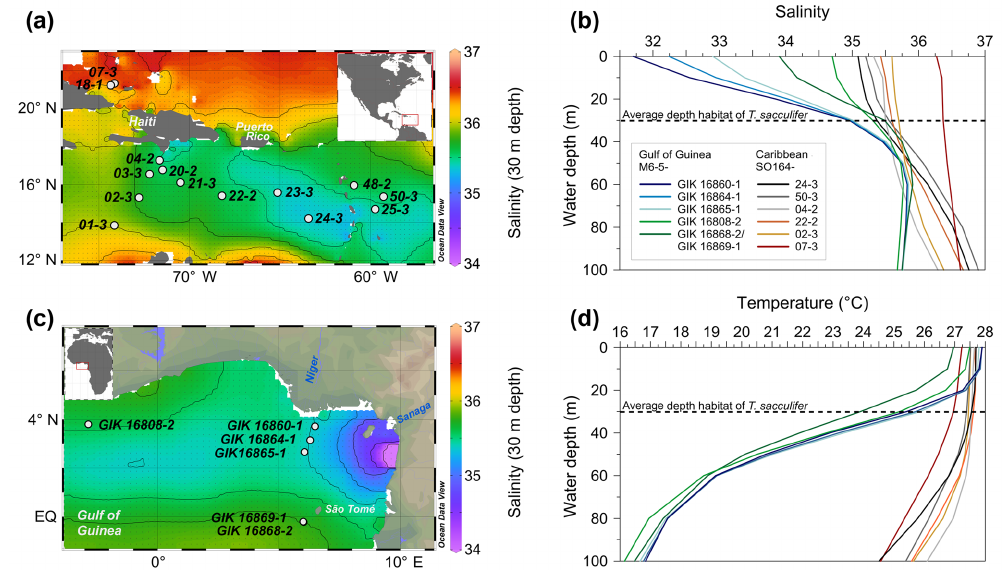
Figure 1. Sediment surface samples used for Na / Ca calibration studies (a–b) and modern hydrography in the study areas (c–d) . (a) Annual sea surface salinity in the Caribbean at 30m of depth (World Ocean Atlas 2013; Zweng et al., 2013). Surface sediments (white dots) were taken during RV Sonne cruise SO164 (Nürnberg et al., 2003). (b) Annual sea surface salinity in the Gulf of Guinea at 30m of depth (World Ocean Atlas 2013; Zweng et al., 2013). Sediment samples (white dots) are from RV Meteor cruise M6–5 (Lutze et al., 1988). Station numbers are indicated (Table 2). Maps were created with Ocean Data View (Schlitzer, 2015). (c) Annual range of salinities and (d) temperatures from 0 to 100m of water depth in the Caribbean and the Gulf of Guinea (World Ocean Atlas 2013; Zweng et al., 2013; Locarnini et al., 2013). Sample stations are color coded (see legend). Stations of Caribbean surface sediments, which are not shown, vary within the black and yellow lines. Station SO164-18-1 equals station SO164-07-3. Data are listed in Table